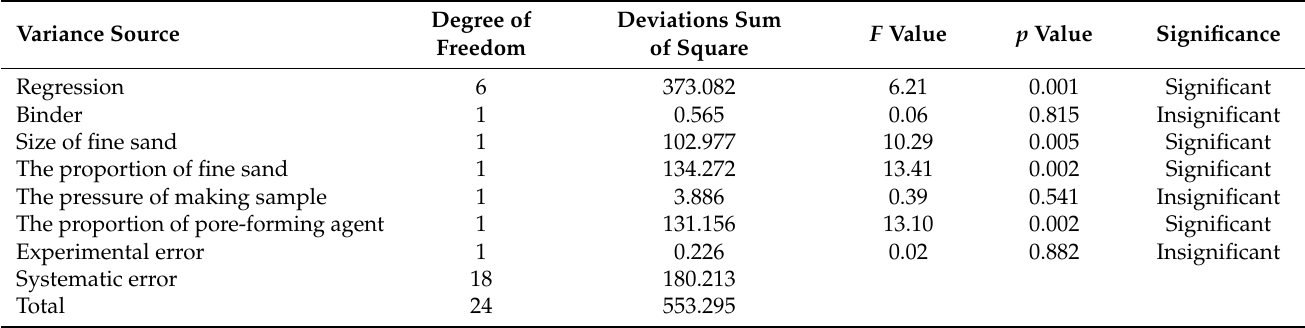
Table 3. Variance analysis of air permeability of nozzle.